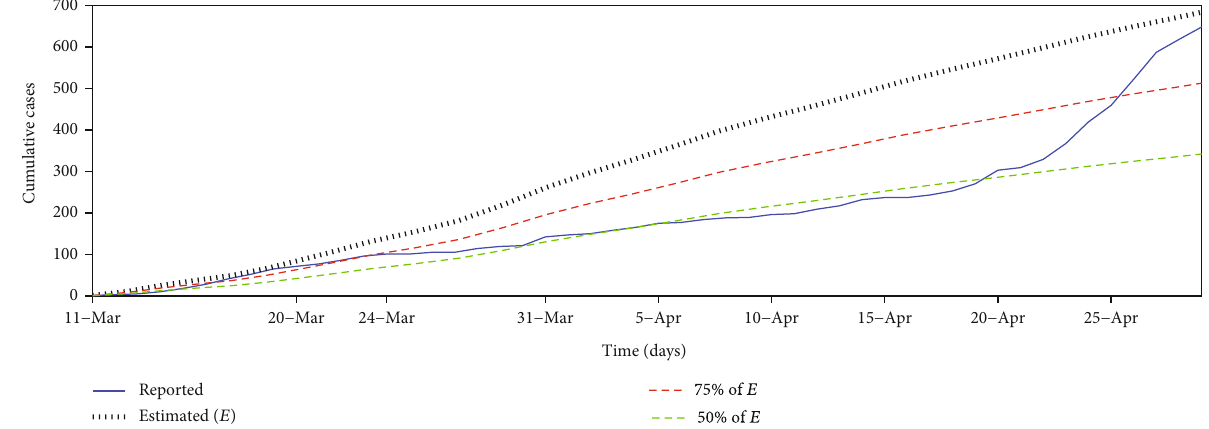
Figure 9: Comparison of actual infected data and simulation results for di ff erent percentage of ρ in Sri Lanka ( ρ is the ratio of symptomatic to total infectious